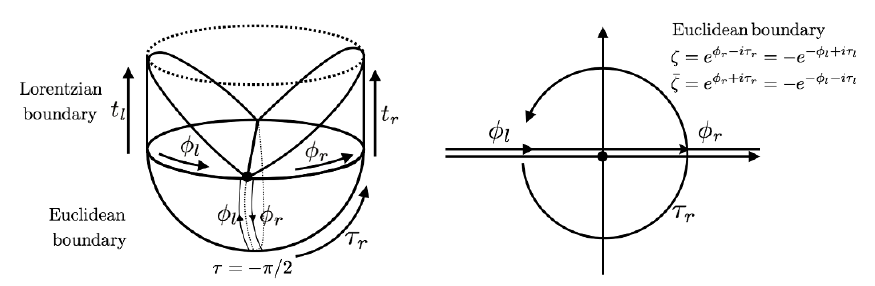
Figure 2 . Rindler coordinate and Euclidean plane de(cid:12)ned on its